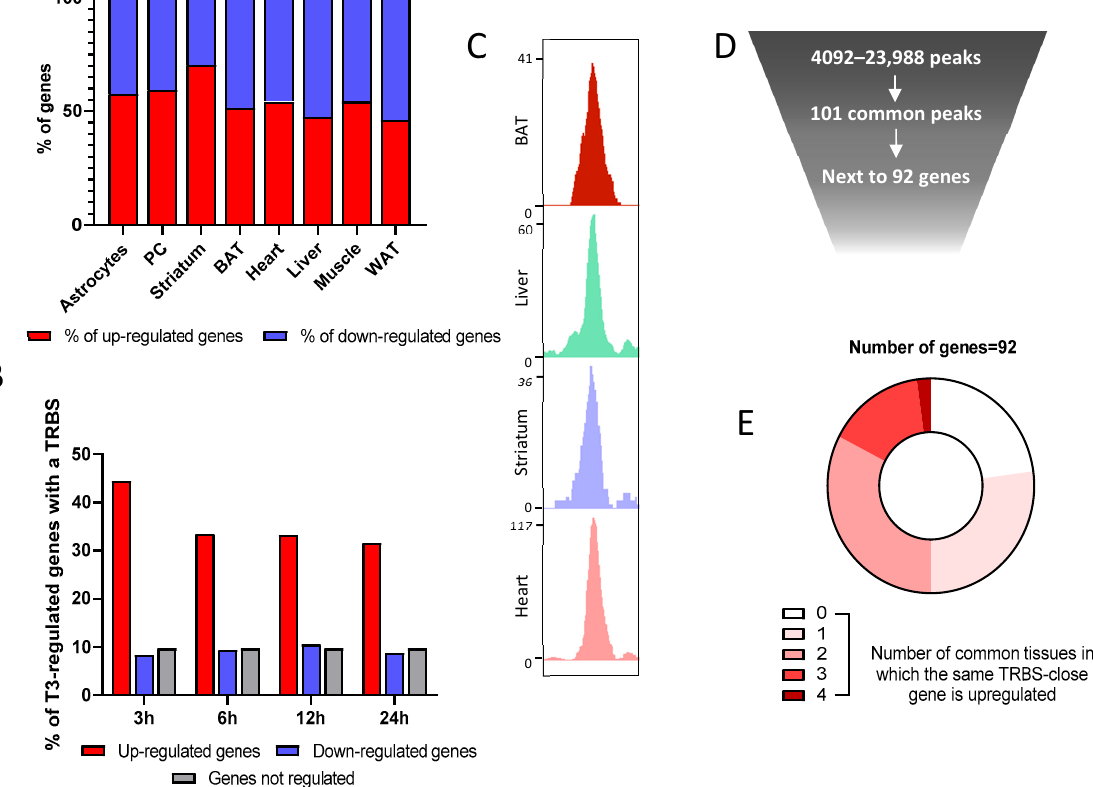
Figure 4. Combined analysis of RNA-seq and ChIP-seq data gives insights into TR mechanisms of action. ( A ) Percentage of genes up- or downregulated by thyroid hormone in the different available tissues. ( B ) Percentage of genes that possess a TRBS within 30 kb of their TSS among genes where the expression in the BAT is either regulated or not by T3 (upregulated in red, downregulated in blue and a set of randomly selected nonregulated genes in grey). ( C ) Integrative Genome Viewer shot of a TRBS shared in the four different available tissues. ( D ) Schematic representation of the rarity of common TRBS. ( E ) Circle diagram of the T3 sensitivity for the 92 genes that are close to the 101 common TRBS. These genes are divided into five categories, decided by in how many of the five tissues their expression is induced by T3.